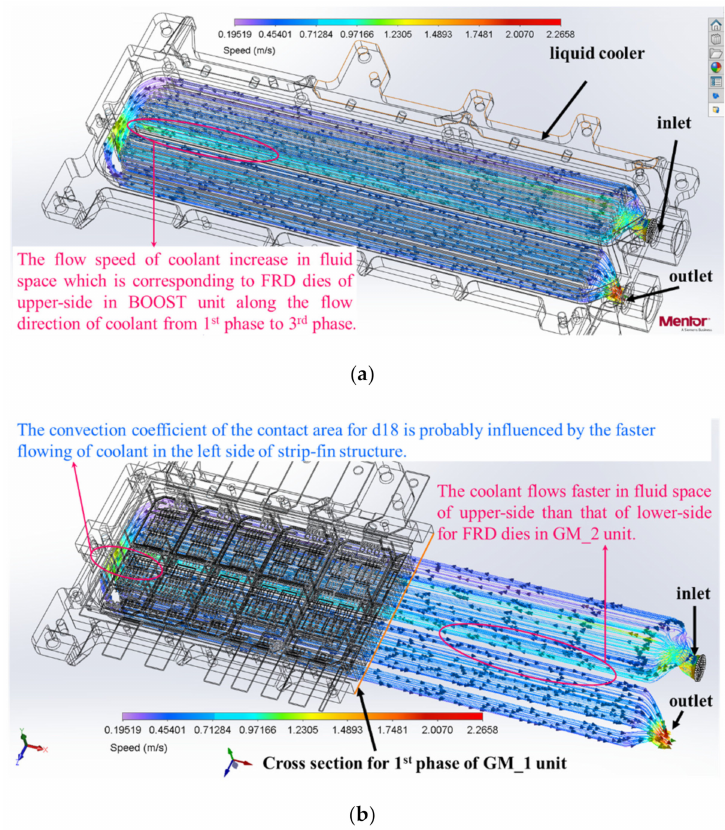
Figure 10. Simulation results of flow speed of coolant in the fluid space of the liquid cooler: ( a ) the view without placement design of power dies and ( b ) the view with placement design of power